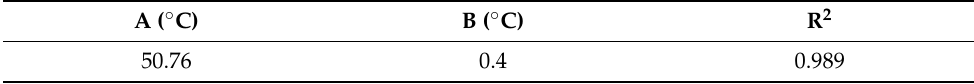
Table 2. Defining parameters of T g evolution ( ◦ C) with the glass fiber volume.